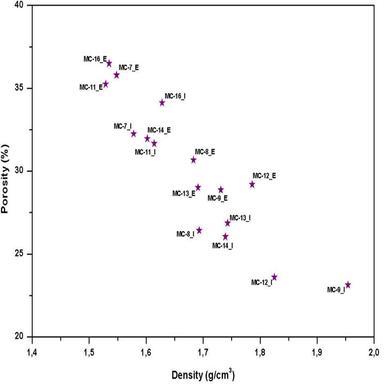
Relationship between bulk density and porosity of the RE samples.